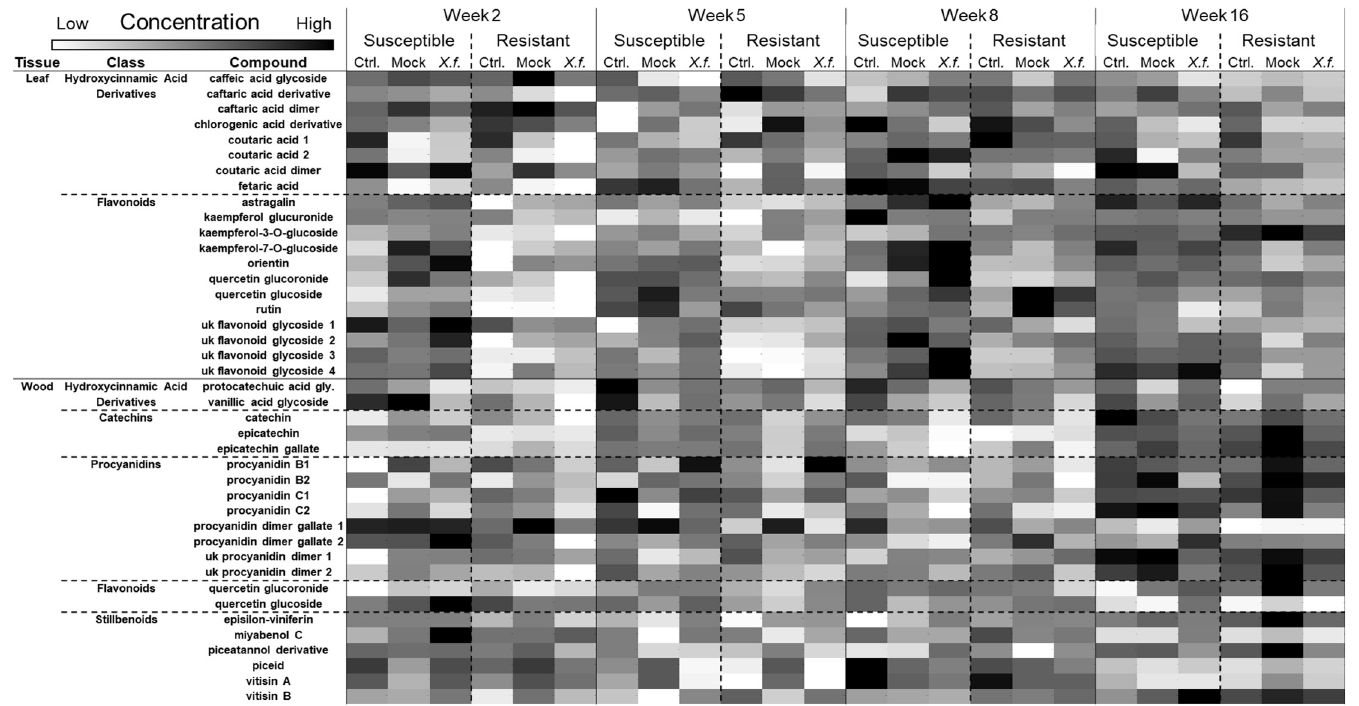
Fig 2. Visual representation of differences in individual phenolic levels of susceptible and resistant grapevines over time. Heat map showing patterns for levels of each individual compounds over time in both foliar and woody tissues, present in either resistant or susceptible grapevines, and in plants receiving the different infection treatments (non-wounded, mock-inoculated, or Xylella fastidiosa -infected), as a visible representation of the data provided in S1 and S2 Tables. Heat maps were done across all treatments and times, with lighter gray representing lowered levels, and darker gray representing increased levels. Refer to S1 and S2 Tables for greater details including standard errors of means and statistical test